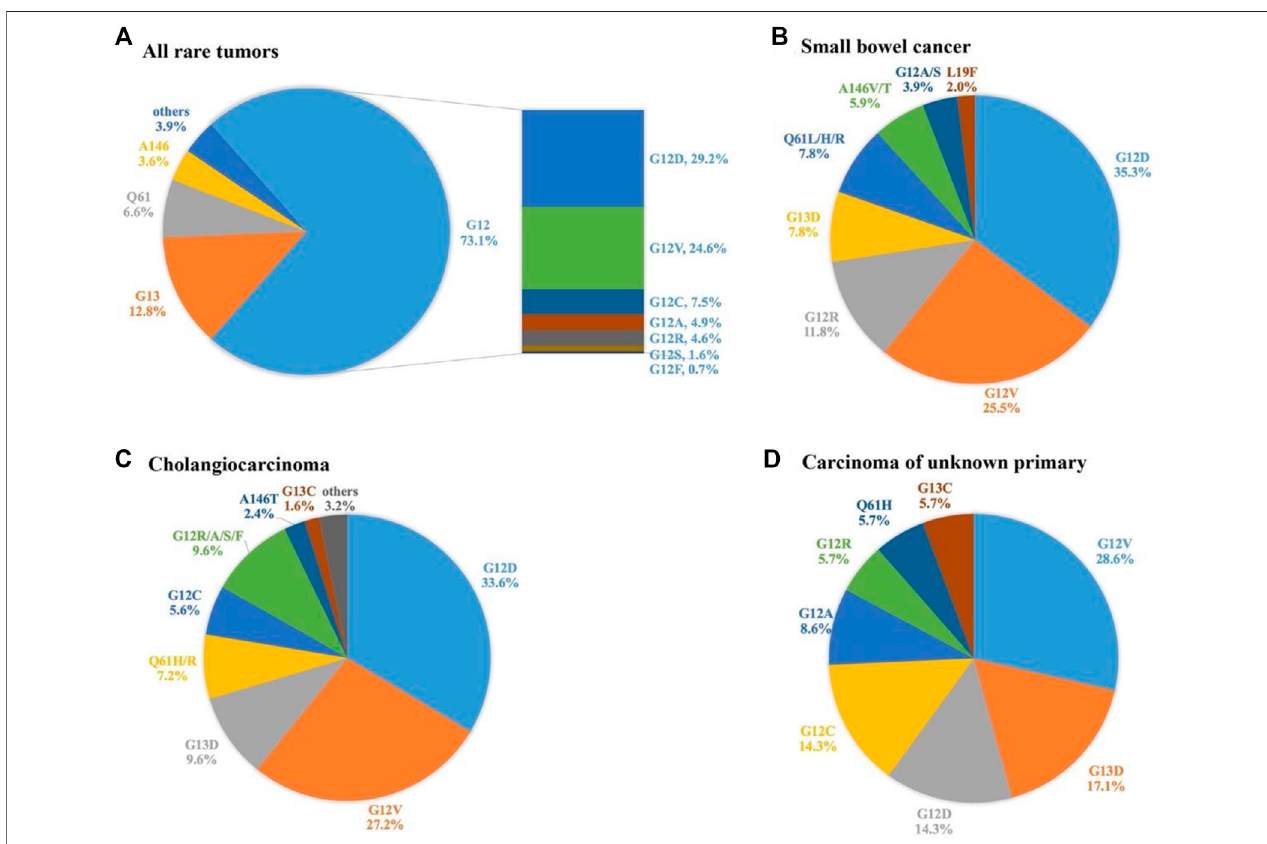
FIGURE 2 | Distribution of KRAS mutations in all rare tumors and three subtypes.